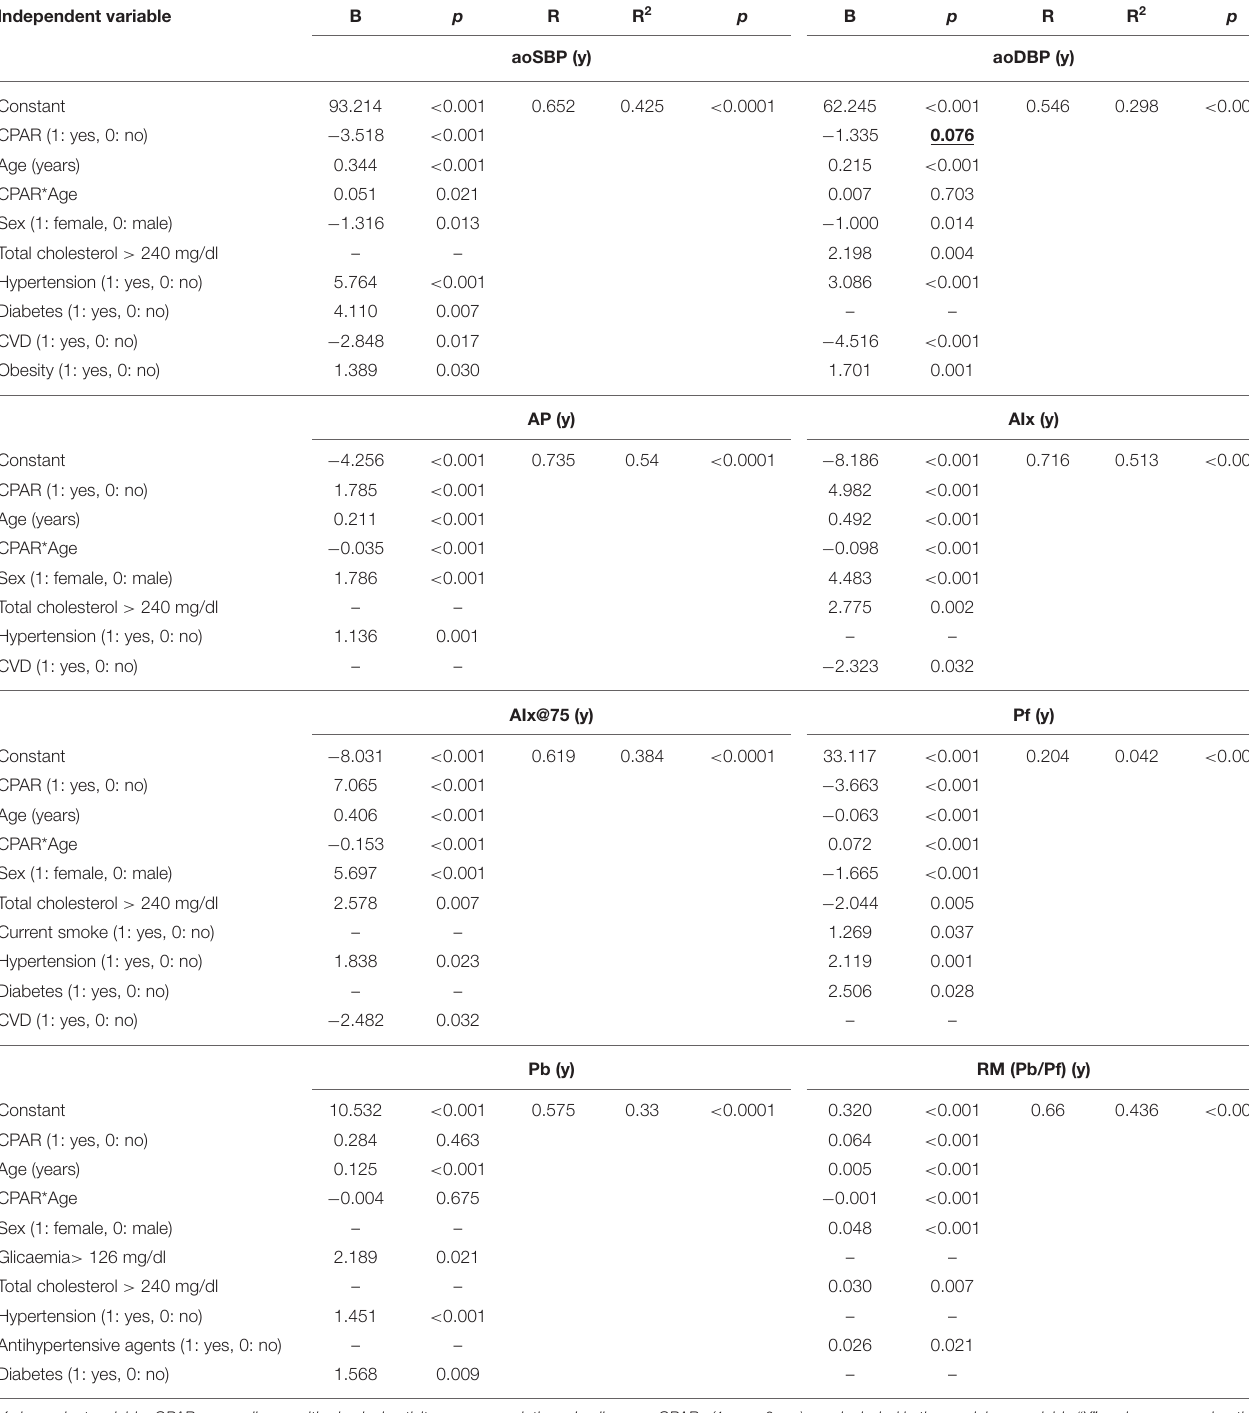
TABLE 5 | Association between CPARs and aortic pressure levels and waveform-derived indexes, with age as a moderating variable. Independent variable B